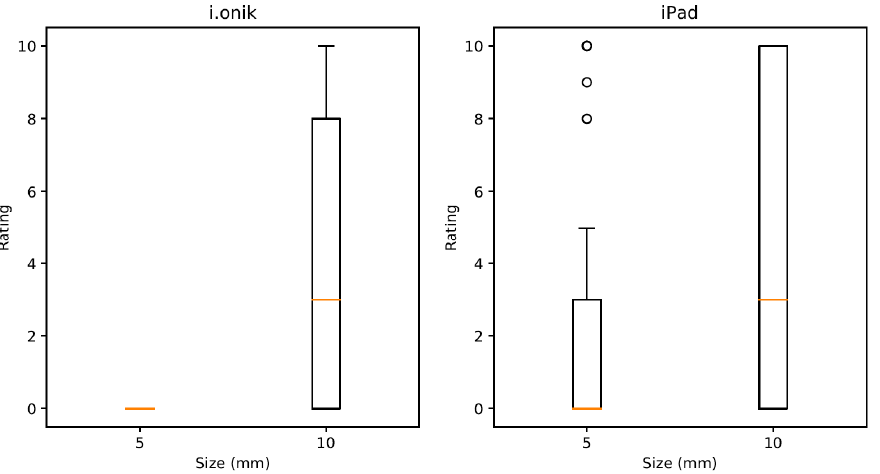
Figure 11. Comparing the two sizes of the capacitive markers regarding the overall detection performance (“Rating”).